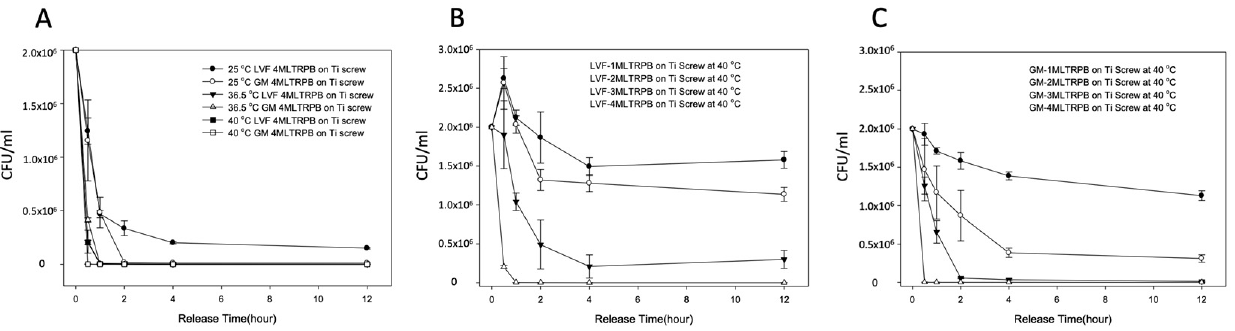
Figure 7. In vitro antibacterial effect of ( A ) LVF or GM released from 4-MLTRPB on Ti screws at 25 °C, 36.5 °C, and 40 °C, ( B ) LVF, and ( C ) GM released from different layers of MLTRPB-Ti screws at 40 °C.